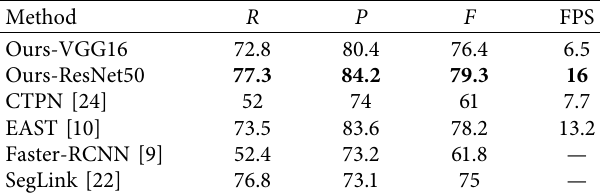
Table 1: Results on the ICDAR2015 dataset.